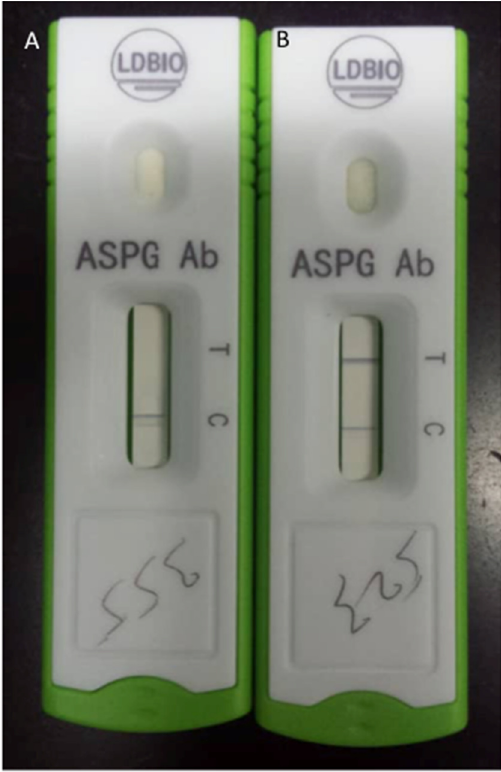
Figure 4. A negative ( A , single line) and a positive ( B , double line) Aspergillus -specific IgM / IgG in a patient with a suspected chronic pulmonary aspergillosis. Images courtesy of Mr. Richard Kwizera.